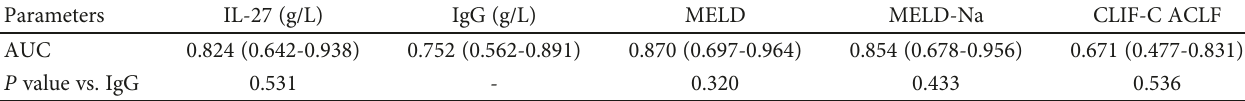
Table 2: Comparisons of the area under the ROC curves (AUCs) estimated for each